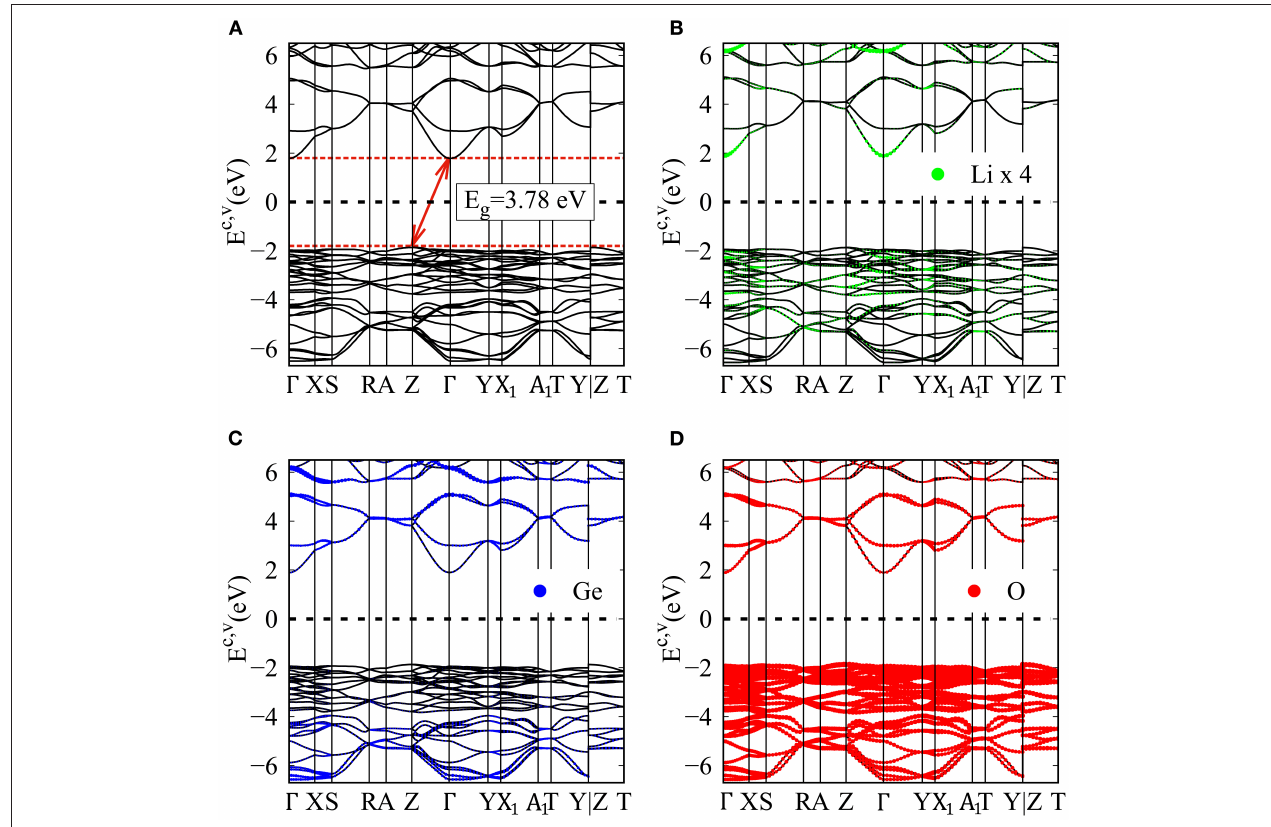
FIGURE 2 | (A) Electronic energy spectrum for the Li 2 GeO 3 compound, for the specific (B) Lithium (enlarge four times), (C) Germanium, and (D) Oxygen